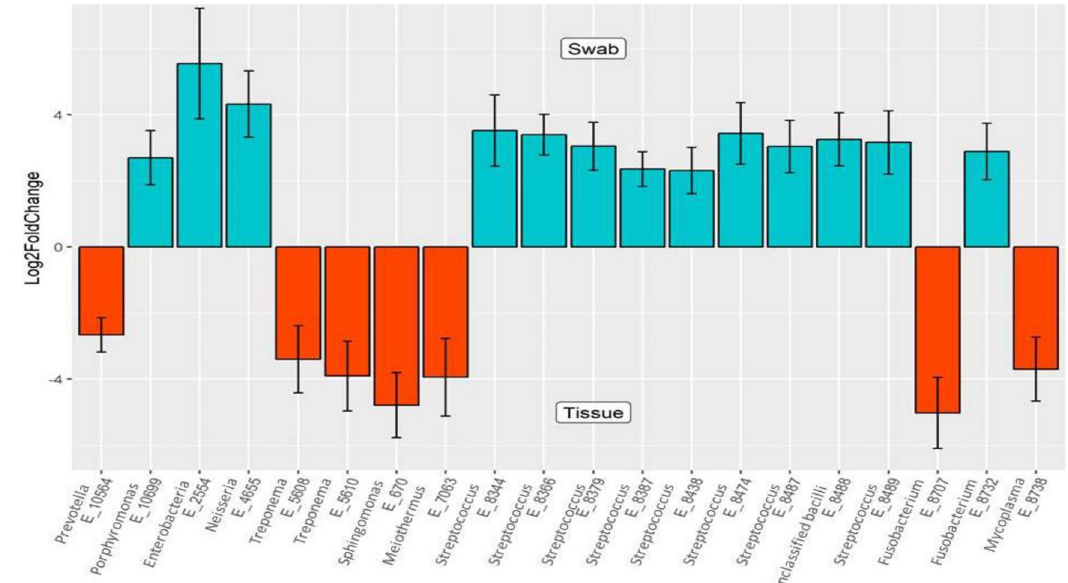
Figure 5. Differentially abundant taxa identified in cancer tissue and tumor surface groups by DESeq2 analysis. Twenty taxa were differentially abundant between the tumor surface and the tumor tissue.